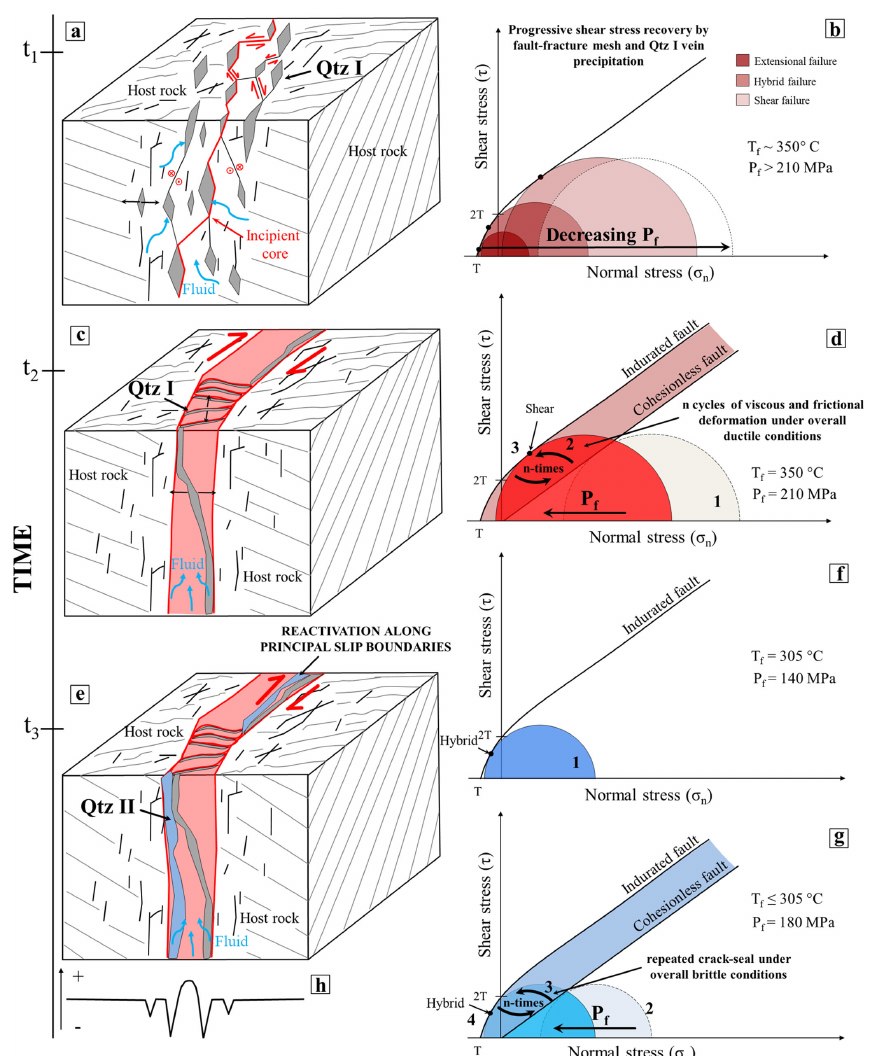
Figure 13. Conceptual model of the temporal and mechanical evolution of the BFZ300 fault zone (see text for more details). Grey lines: traces of metamorphic foliation. Black lines: fractures related to the BFZ300 structural development. (a) Initial embrittlement of the migmatitic basement occurred by fracture coalescence (red line) under (b) initial lower differential stress conditions and high fluid pressure, followed by a transient increase in differential stress. A first generation of quartz veins (Qtz I) precipitated inside the diffuse network of joints and hybrid–shear fractures which formed during this first deformation stage. (c) Progressive strain localization and fluid channelling within the fault core occurred by (d) episodically renewed fluid pressure build-up driven by cycles of brittle and ductile deformation. (e–g) Progressive exhumation and cooling of the fault system occurred concomitant with several brittle reactivation episodes of the fault zone under hybrid conditions and fluid pressure lower than during the previous deformational stages. Lastly, a second generation of quartz veins (Qtz II) was emplaced, mainly along the principal slip boundaries of the fault core, following the Qtz I vein as shown by (h) the strength profile across the fault architecture, which suggests lower tensile strength values (and hence higher reactivation potential) along the Qtz I vein and host-rock